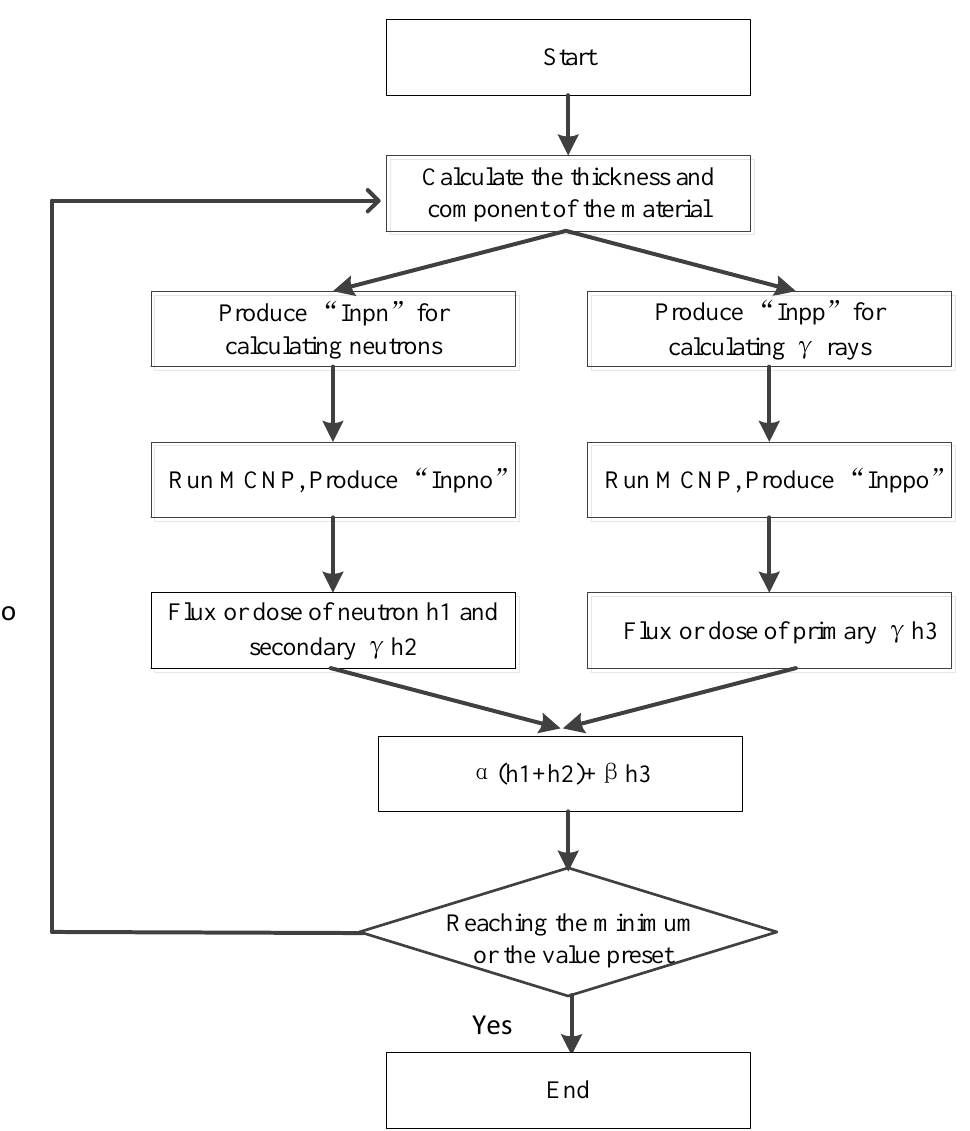
Figure 2. Flow chart of representing the structure and components of the